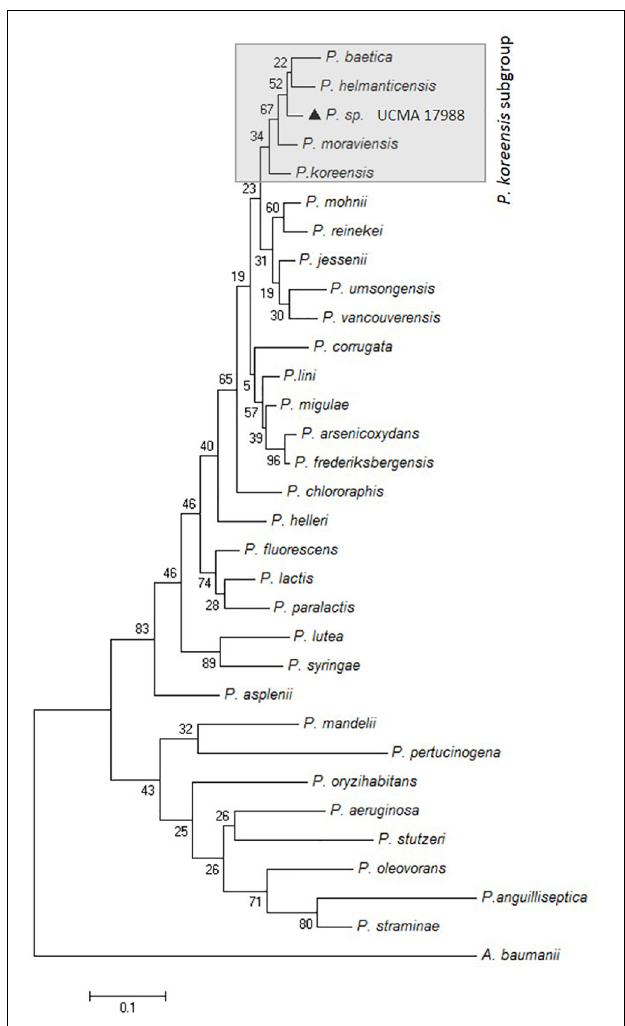
FIGURE 1 | Maximum-likelihood phylogenetic tree based on partial rpoD gene sequences (727 nt) of Pseudomonas sp. UCMA 17988 ( (cid:78) ) and closely related species. The percentage of replicate trees in which the associated taxa clustered together in the bootstrap test (1000 replicates) is shown next to the branches. Acinetobacter baumannii was used as an outgroup.